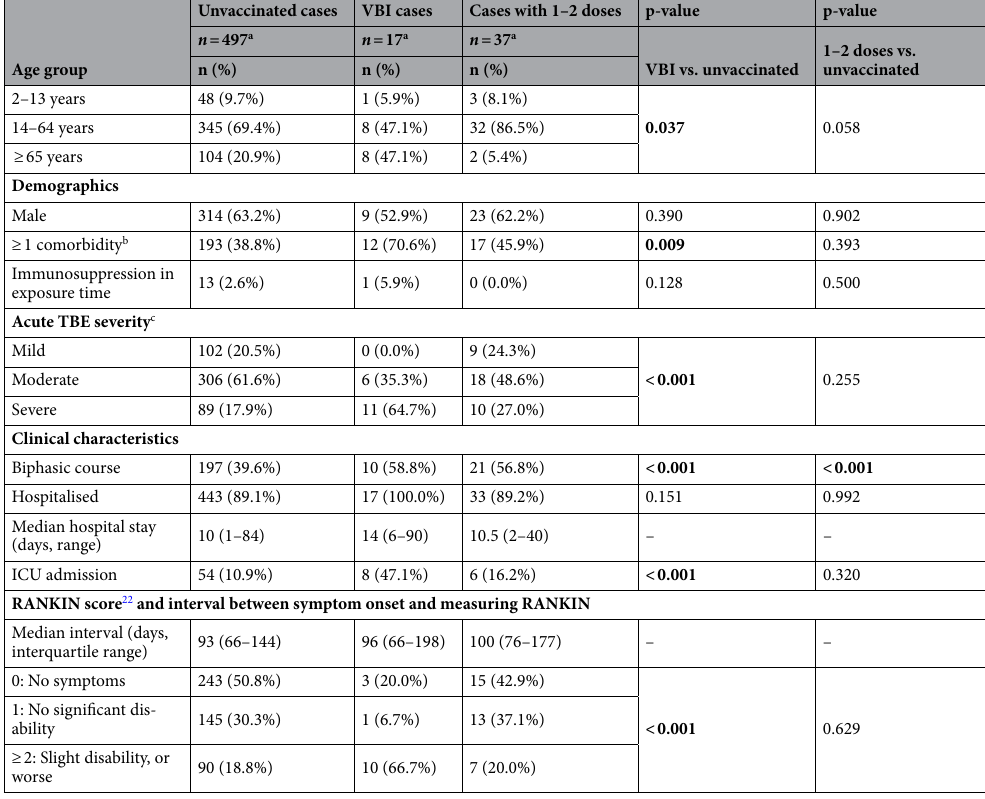
Table 3. Characteristics and acute TBE manifestations in previously unvaccinated TBE cases, cases with vaccination breakthrough infections, and cases with incomplete TBE vaccination at 1–2 doses. Significant values are in bold. a Of these, 478 unvaccinated cases, 15 VBI cases, and 35 cases with 1–2 doses had interview data. These denominators were used to calculate proportions within purely interview-derived variables (RANKIN score). b From medical data sources and self-reported, for details see Ref. 20 . c As defined in Ref. 20